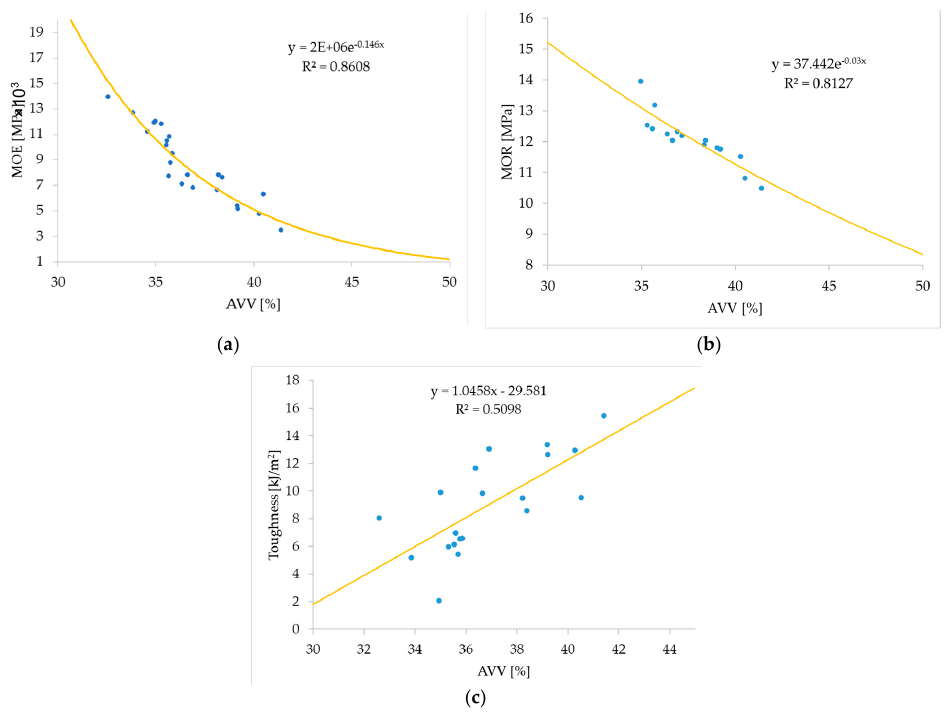
Figure 10. Relationship between mechanical properties and apparent void volume (AVV): ( a ) MOE; ( b ) MOR; and ( c ) toughness.